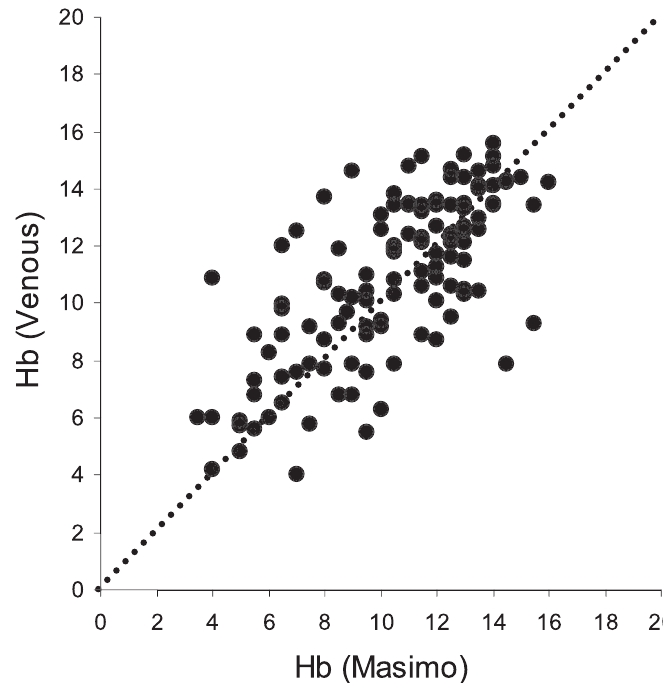
Figure 1. Scatter plot of Masimo hemoglobin (Hb) values versus laboratory hemoglobin values. Dotted line represents 1:1 line of equivalency.